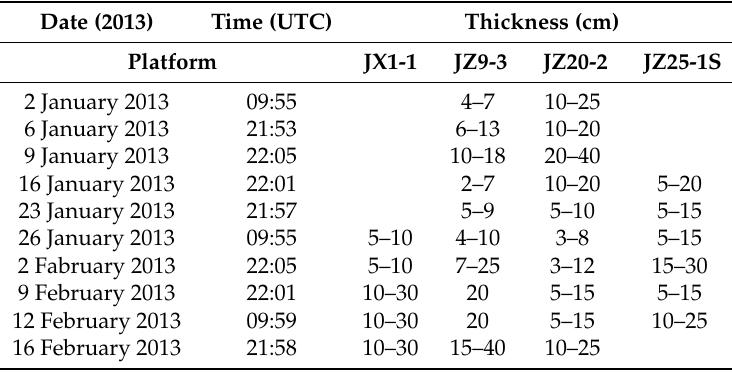
Table 2. Ice thickness in-situ measurements in the Liaodong